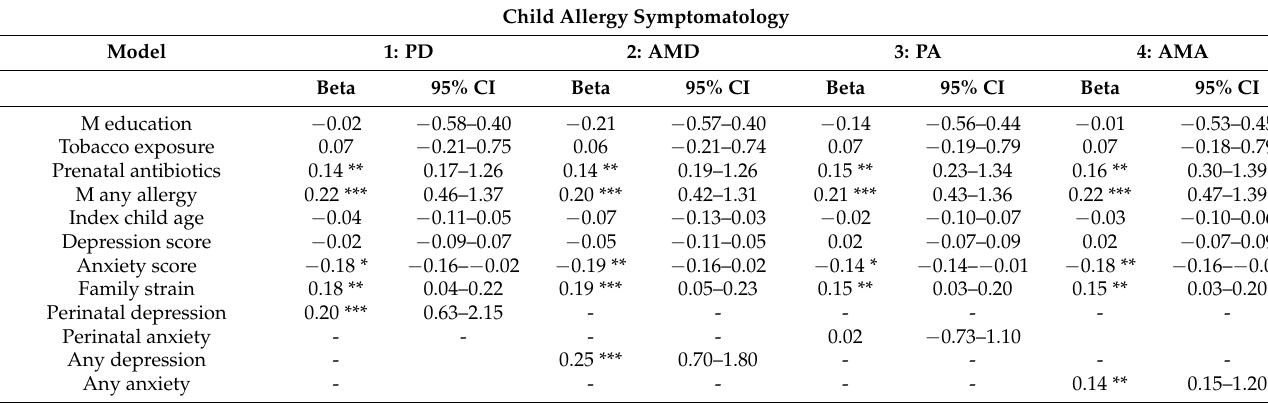
Table 4. Linear regressions of exposure to maternal distress (perinatal and any time) and family strain as predictors of child allergic symptomatology adjusted for known predictors, current mental health and education. Child Allergy